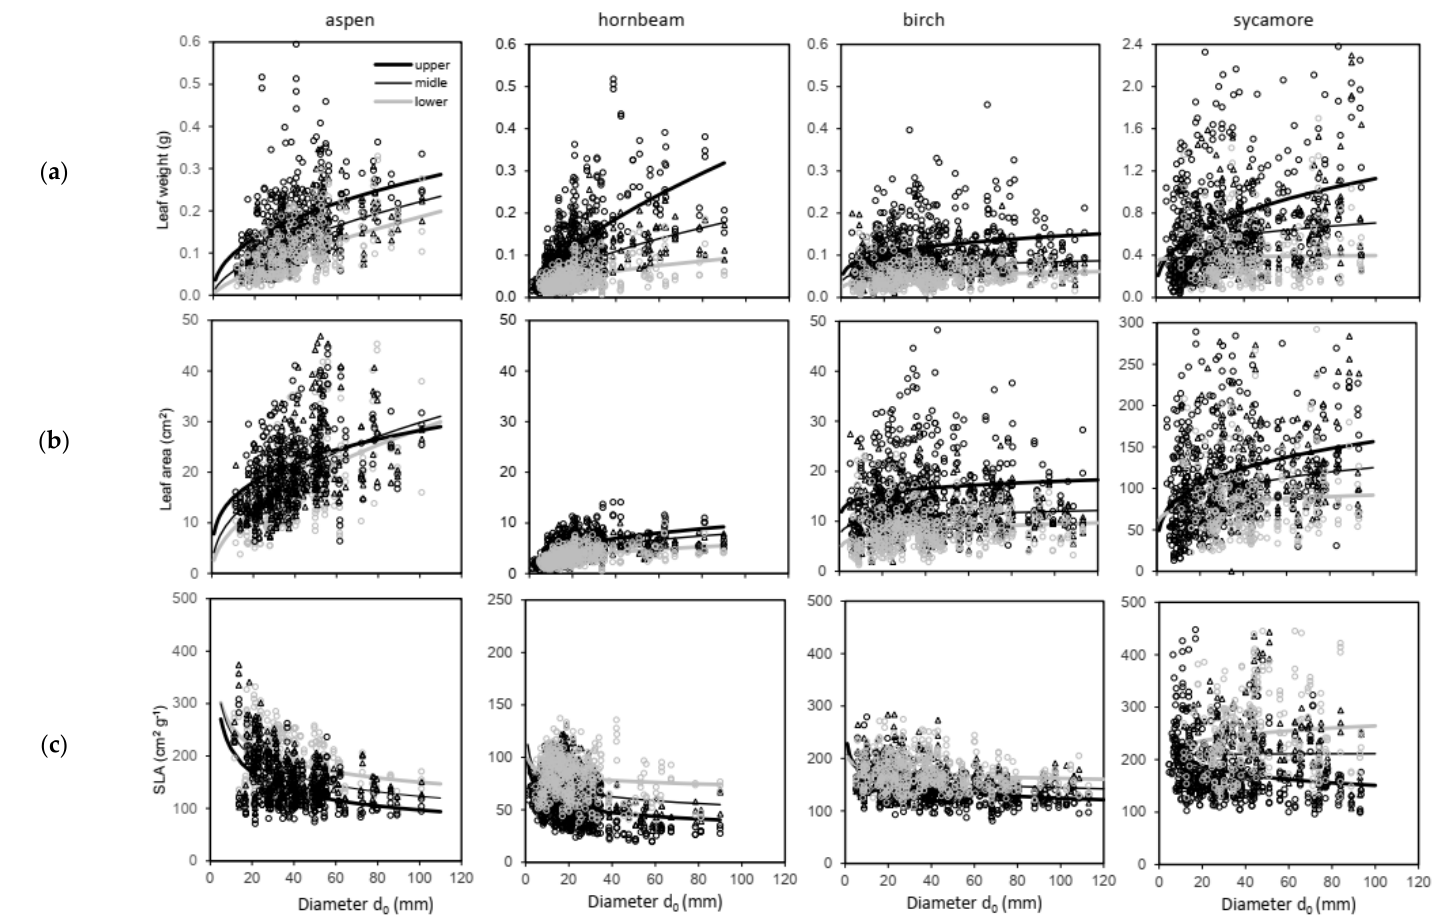
Figure A1. Species-specific models for individual leaf weight ( a ), leaf area ( b ), and specific leaf area (SLA, ( c )) expressed for three parts of vertical crown profile, i.e., upper, middle and lower third against diameter d 0 .